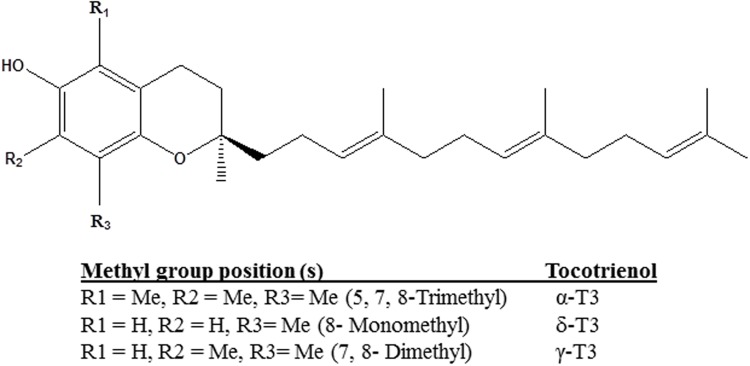
Chemical structures of tocotrienol isomers.